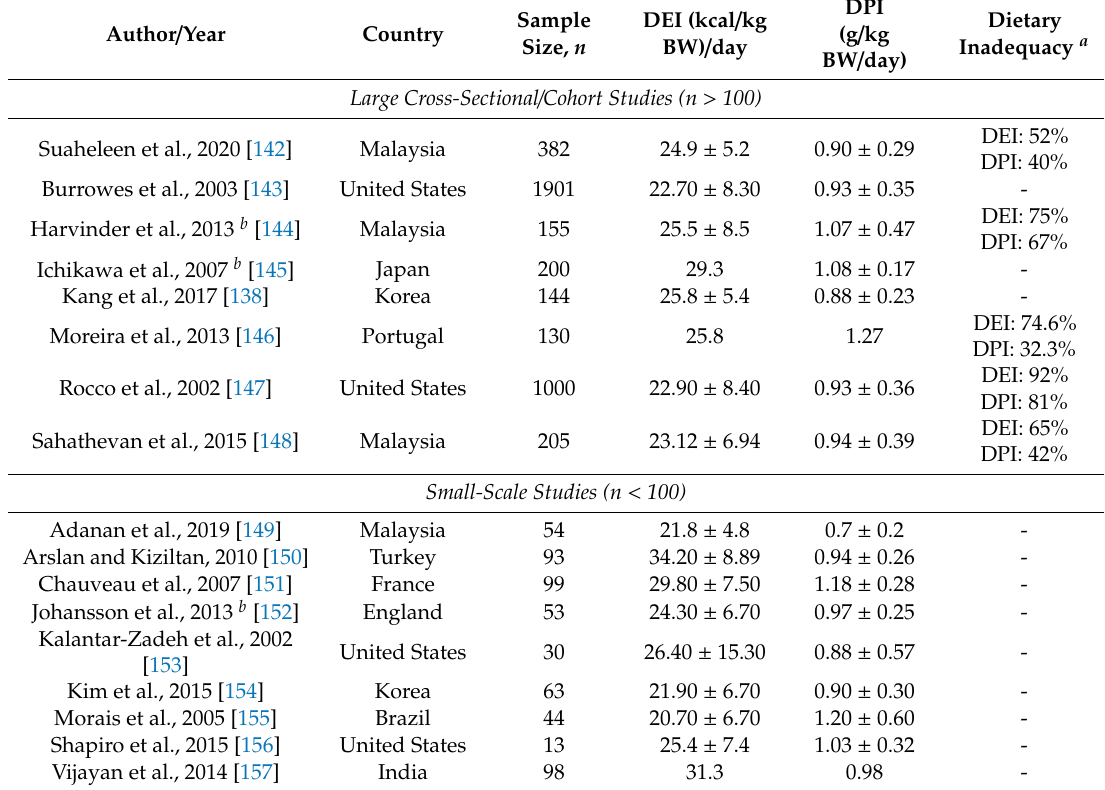
Table 5. Inadequate DEI and DPI in global HD